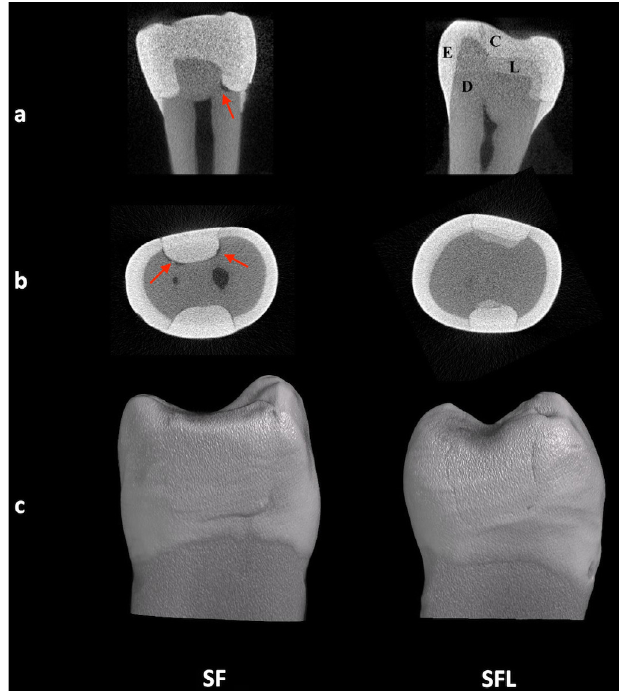
Figure 5- Representative two-dimensional (2D) and three-dimensional (3D) images of sonic-activated bulk-fill composites by micro-CT. Presence of gap formation is noted at the tooth-restoration interface (arrows). Illustrative 2D images of the specimens are visualized: sagittal section (a) and axial section (b). 3D volume rendering of the specimens (c). E, enamel; D, dentin; C, composite; SF, SonicFill 2; SFL, SonicFill 2 with